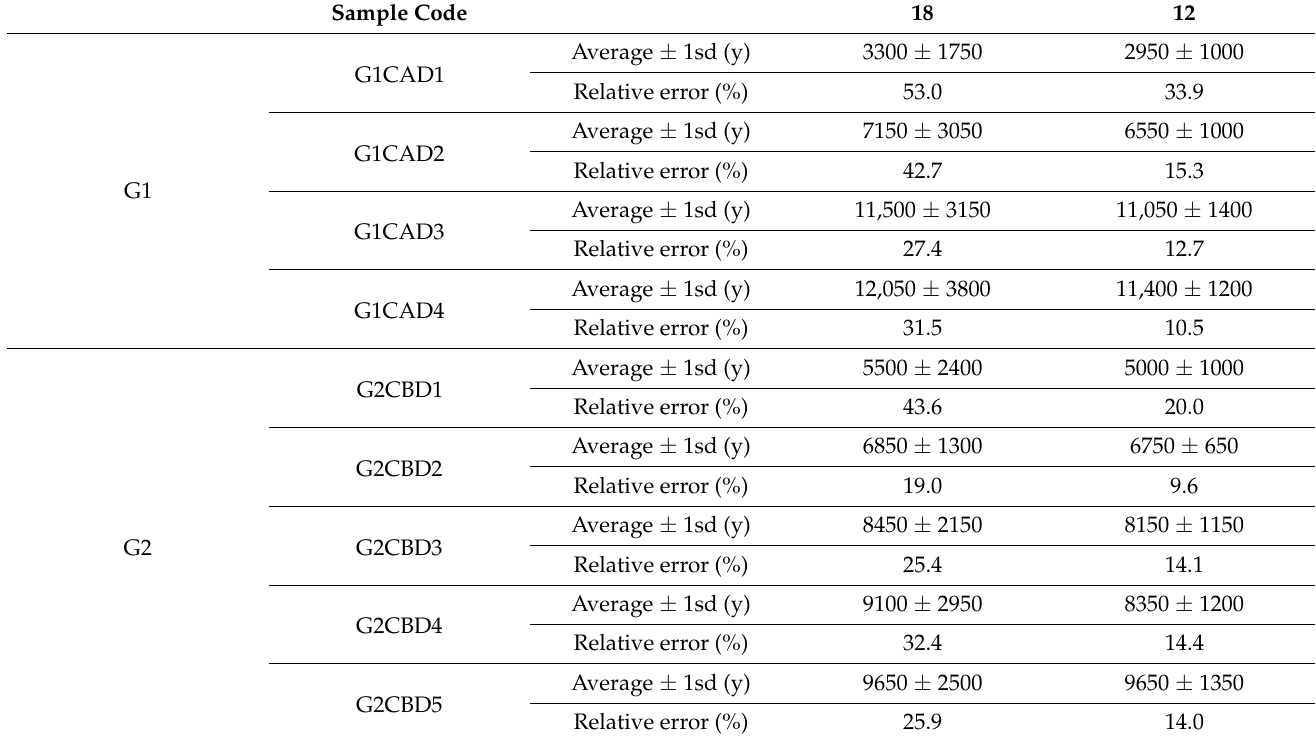
Table 9. Calculated age averages with the associated standard deviation considering the total number of disks ( N = 18) and excluding some of the values ( N = 12). Values are rounded to multiples of 50